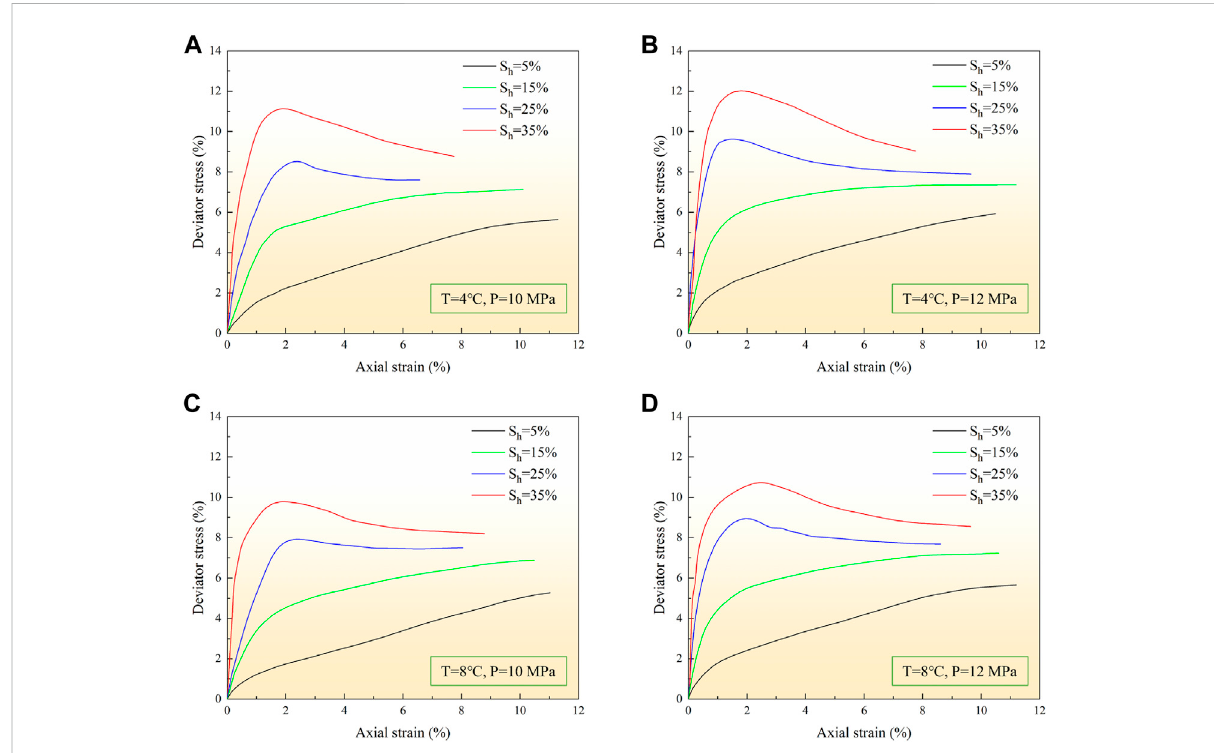
FIGURE 8 Stressstraincurvesatdifferenttemperaturesandpressures. (A) Thestress-straincurveunderreservoirtemperatureof4 ° Candporepressureof